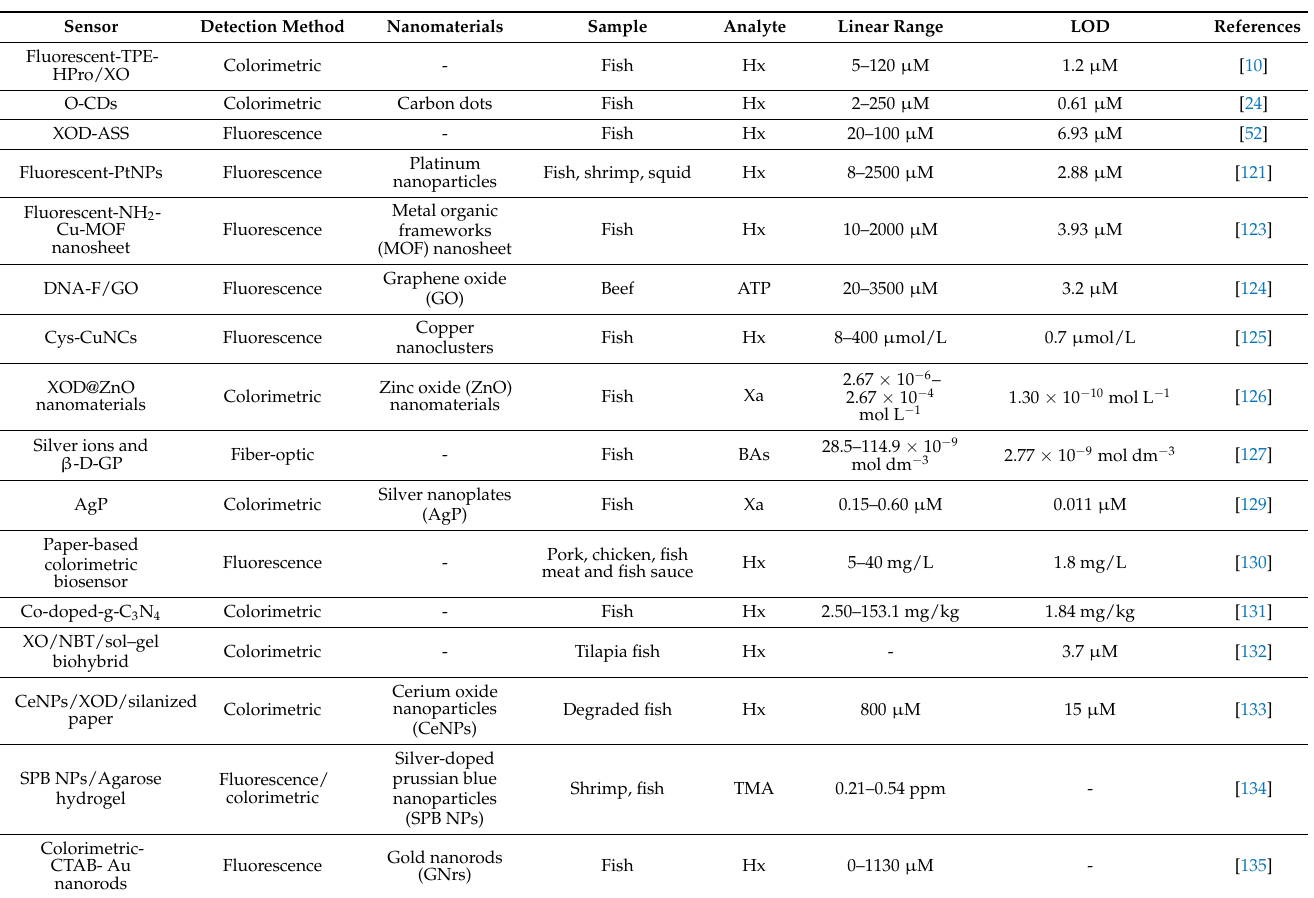
Table 3. Recent trends of optical biosensors in detecting meat freshness and their analytical perfor- mance in food